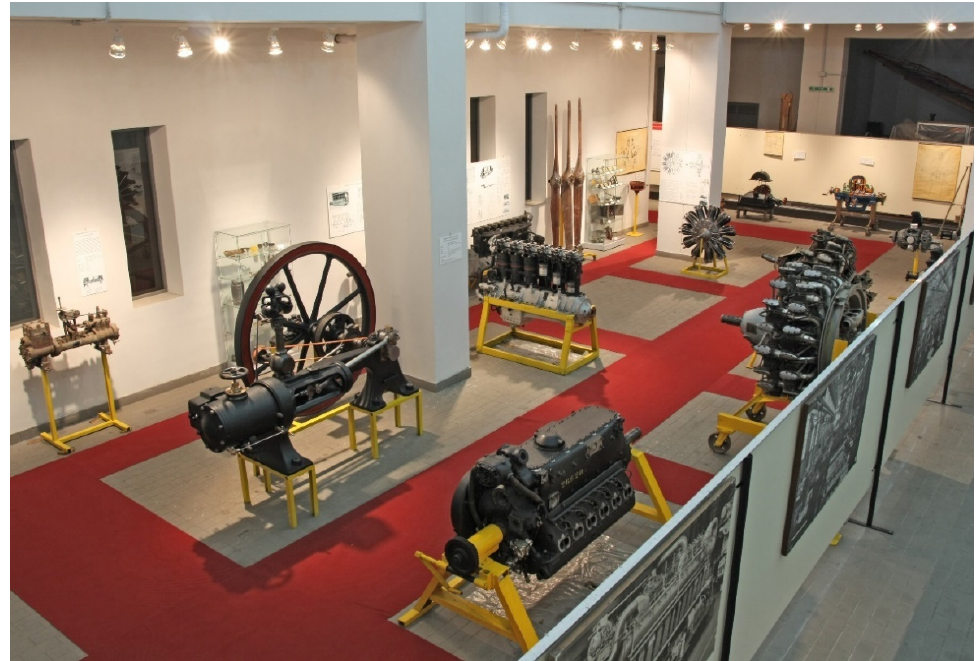
Figure 20. A view of the main exhibition room of the Museum of Engines and Mechanisms at University of Palermo, with engines form several periods and several applications.